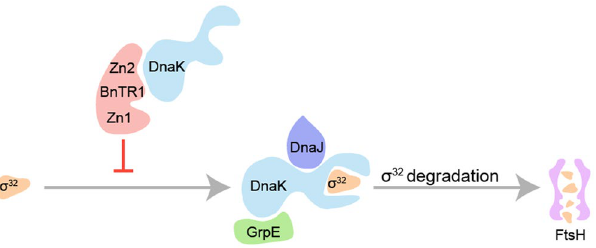
Figure 5. Proposed model of σ 32 accumulation in E . coli cells expressing BnTR1. In wild-type E . coli cells, the KJE chaperone team interacts with σ 32 to inhibit its activity, and then facilities σ 32 degradation by the protease FtsH. In E . coli cells expressing BnTR1, the Zn2 in its RING domain of BnTR1 may interact with DnaK, thereby stabilizing σ 32